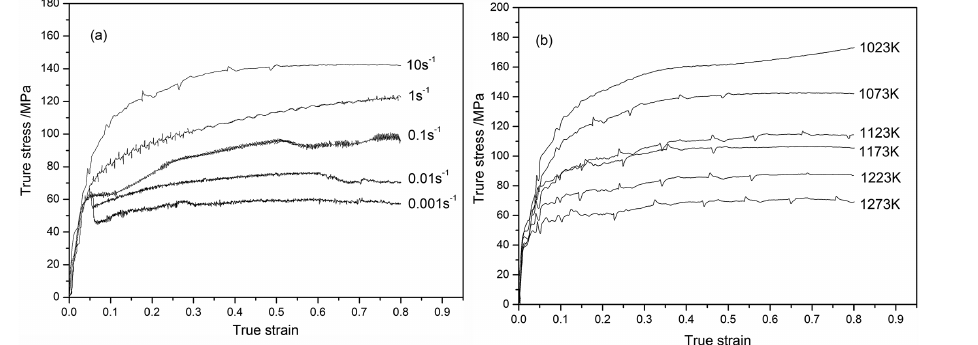
Figure 3: Flow curves of BFe10-1-2 cupronickel alloy obtained at various deformation conditions (a) 1,073K, (b) 10s − 1